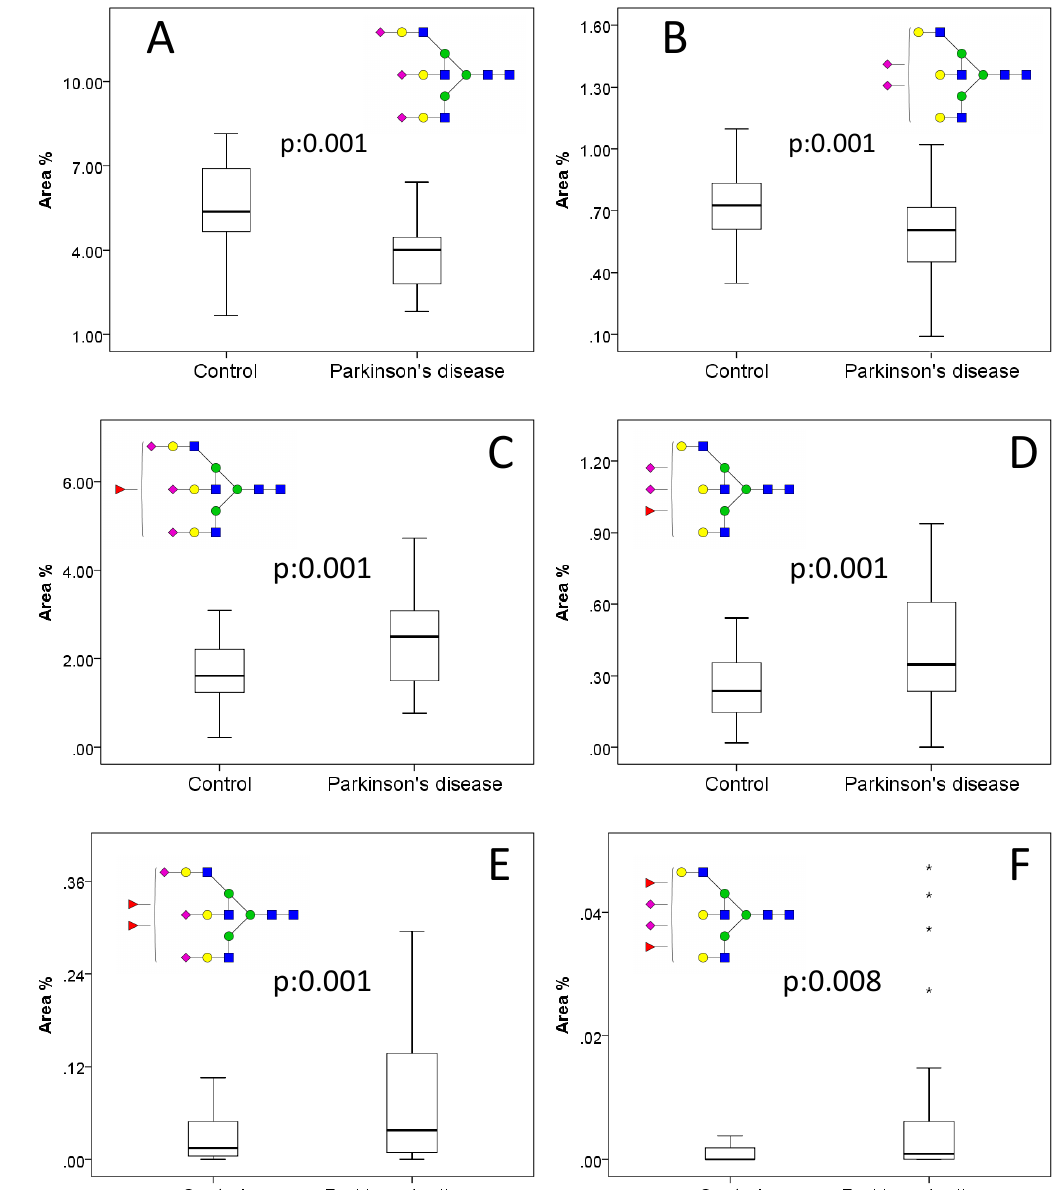
Figure 2. Significant serum N-glycan alterations in Parkinson’s disease on tri-antennary glycans with 137 ( A , B ) no fucose, ( C , D ) 1 fucose, and ( E , F ) 2 fucoses. 138 Due to the high number of significant alterations, SVM-RFE was applied to both female and 139 male datasets. Analysing females, the highest cross-validation score was 0.63 when 11 features were 140 M4A1G1S1, M5A1G1, M5A1G1S1, M6) resulting in a poor classification as is shown in Figure S10 142 (Supplementary Materials). In males, 8 structures were selected with a cross-validation score of 0.86, 143 suggesting a clear classification of control and PD groups (Figure 3A). Selected structures were as 144